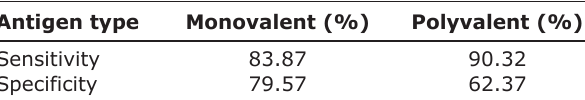
Table-2: The diagnostic sensitivity and specificity of dot blotting using monovalent and polyvalent antigen of live attenuated African horse sickness virus vaccine compared to blocking ELISA.